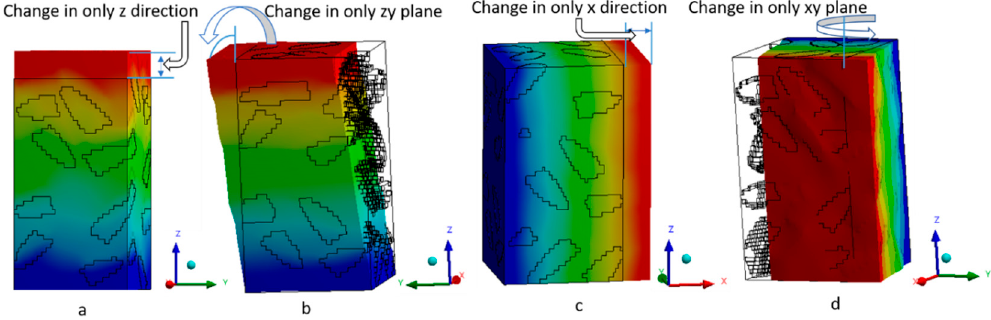
Figure 8. Conditions after analysis, ( a ) pure tension in z; ( b ) pure shear in zy plane; ( c ) pure tension in x; and ( d ) pure shear in the xy